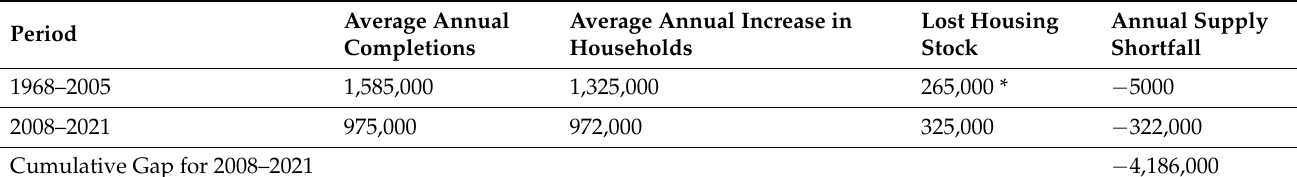
Table 4. Supply Shortfall Based on Household Formations